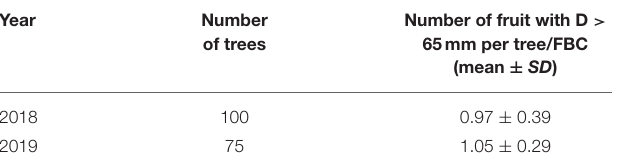
TABLE 3 | The ratio between the actual number of fruit per tree with diameter (D) > 65mm considering all fruit measured when harvesting whole trees and modeling